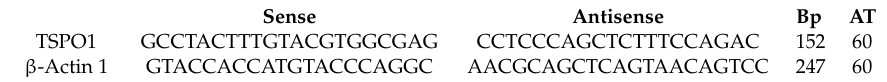
Table 1. List of primers used in this study (AT—annealing temperature; bp—base pair length)